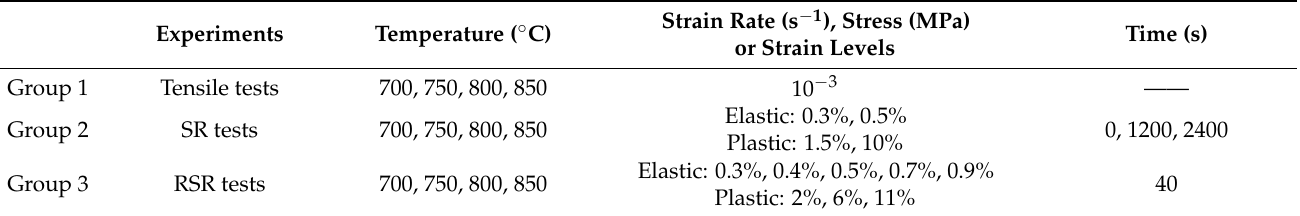
Table 1. Experimental design for the uniaxial tensile, stress relaxation (SR) and repeated stress relaxation (RSR).